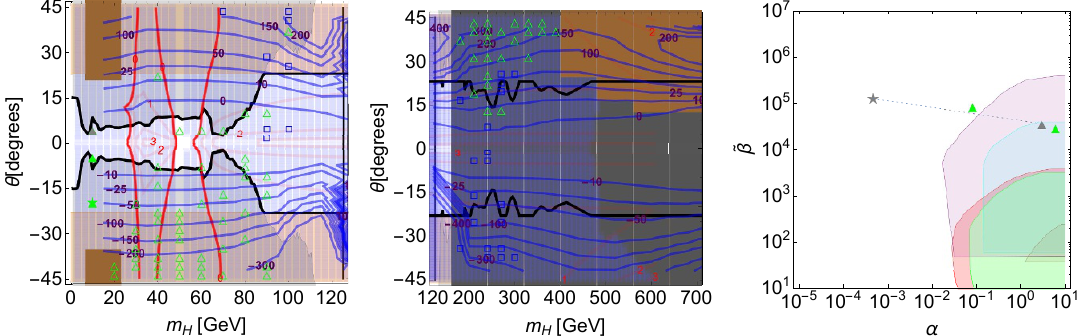
Figure 7 . Types of multi-step PT for m X = 25 GeV, g X = 0 . 5 ( v S = 50 GeV). See the captions of figures 3–4.